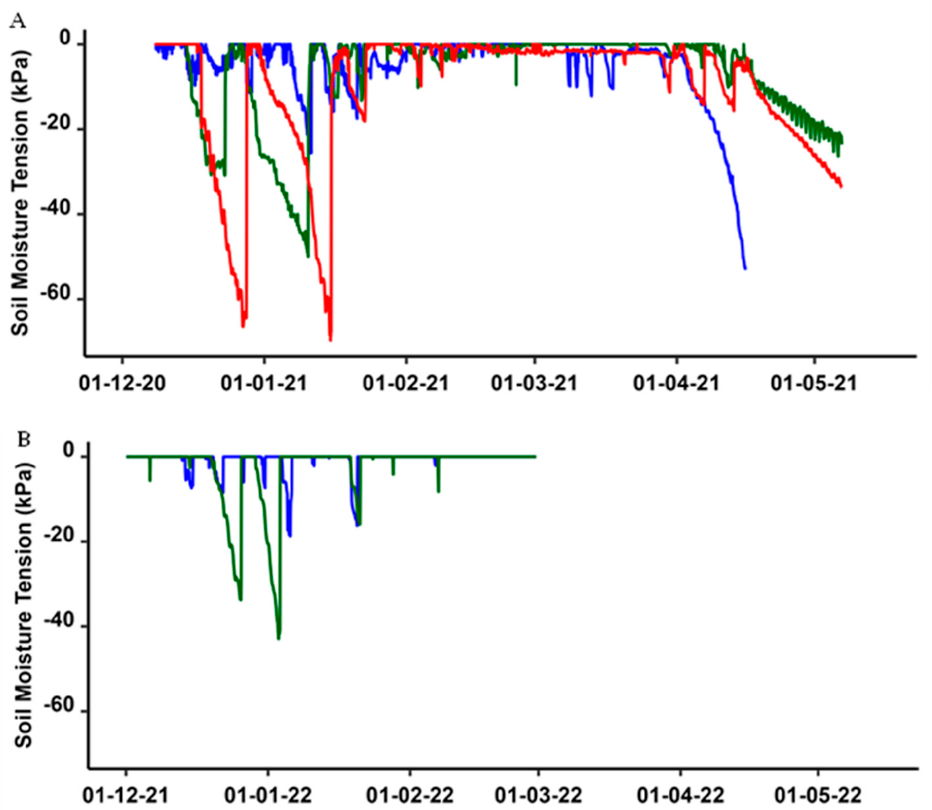
Figure 4. Soil moisture tension during the vegetative period when irrigation scheduling treatments were enforced; ( A ): Year 1 (above), ( B ): Year 2 (below), 15 kPa (green), 40 kPa (blue), 70 kPa.